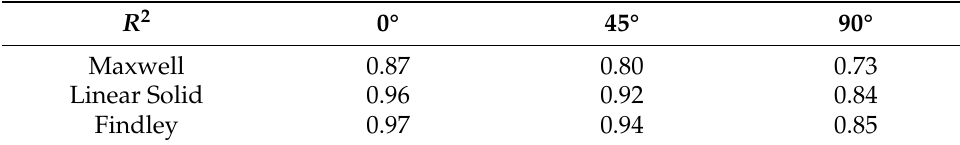
Table 6. Analytical models R-squared values for the 0°, 45° and 90° infill orientation.